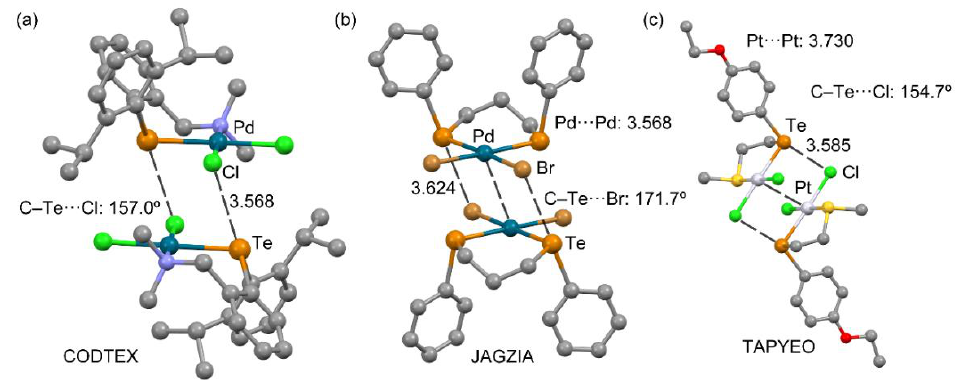
Figure 12. Partial views of the X-ray structures of CODTEX ( a ), JAGZIA ( b ) and TAPYEO ( c ). Distances in Å. H-atoms omitted for clarity.